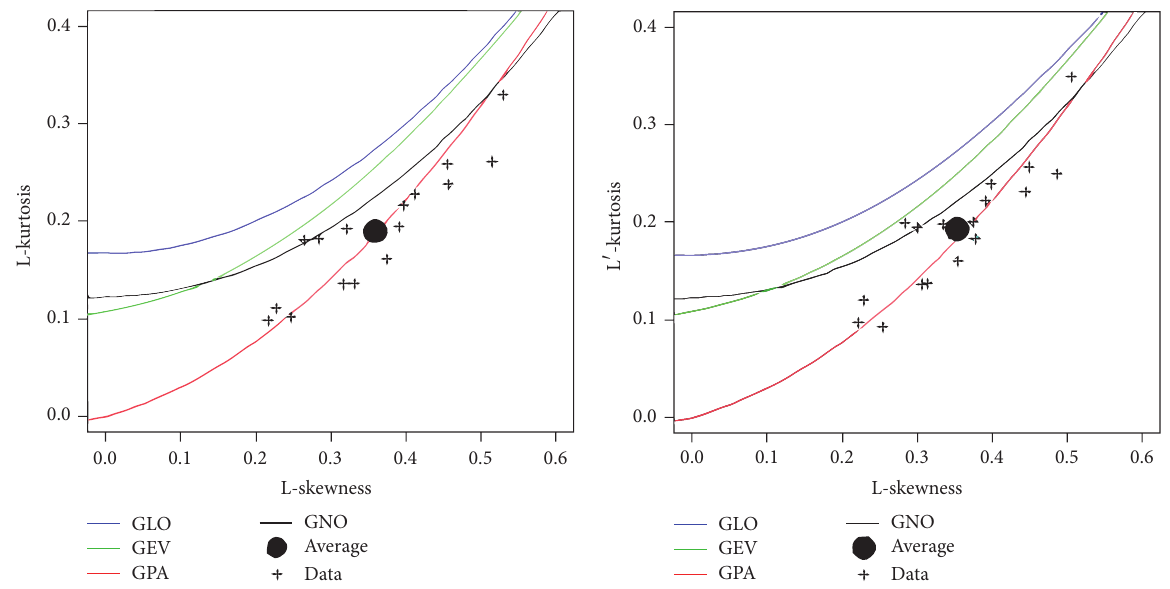
Figure 2: L-diagram and PL-diagram of the GLO, GEV, GPA, and GNO distributions.